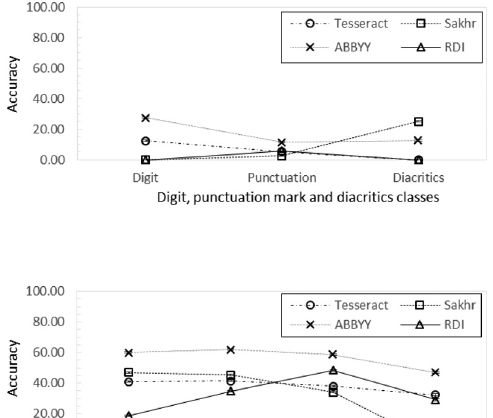
Figure 9. Arabic OCR accuracy versus font pitch size results from the OCR system evaluation